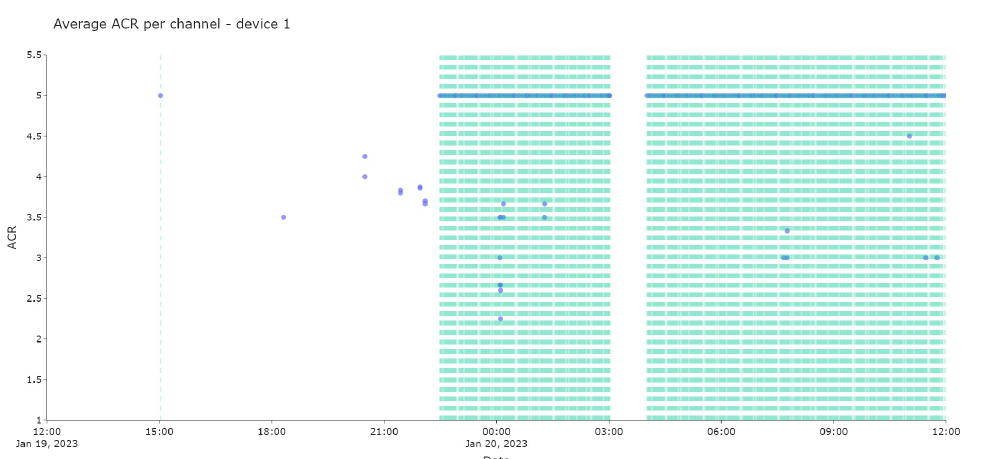
Figure 12. Average ACR grade for given channel for first device.